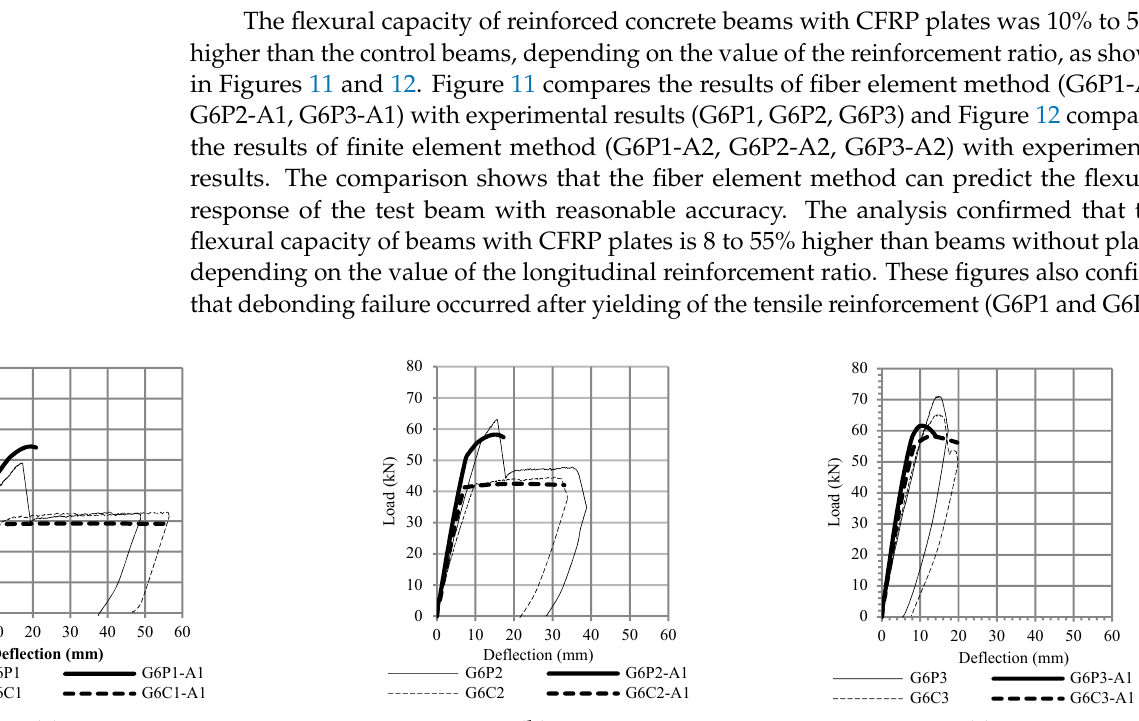
Figure 10. Load-deflection curve from the tested beams ( a ) control beams, and ( b ) beams with CFRP plates.